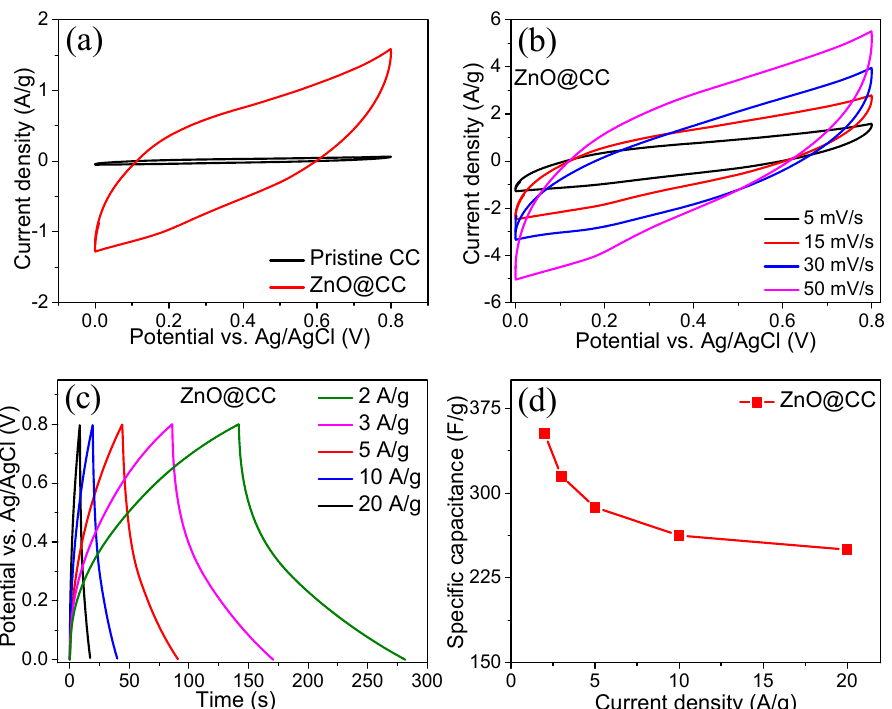
Figure 5. ( a ) CV curves of pristine CC and ZnO@CC, ( b ) CV curves of ZnO@CC, ( c ) GCD curves of ZnO@CC, and ( d ) Specific capacitance vs. current density.